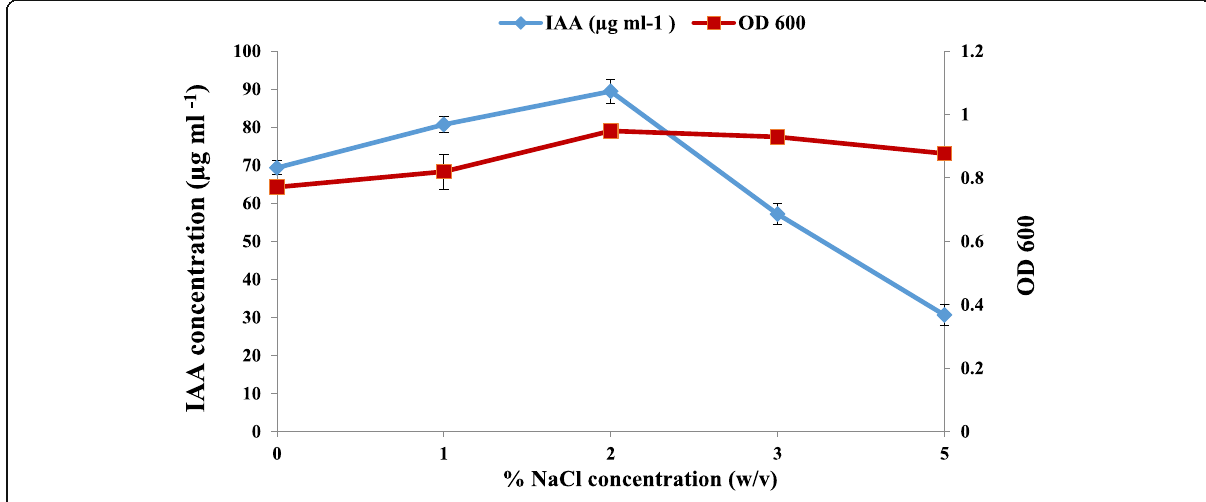
Fig. 4 Effect of NaCl concentrations on Rhizobium sp. growth and IAA